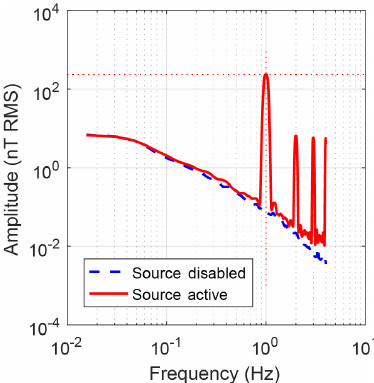
Figure 11. Amplitude spectra showing representative noise envi- ronment of the laboratory (blue; dashed). Equivalent spectra with a sinusoidal test signal applied using the Helmholtz coil (red;